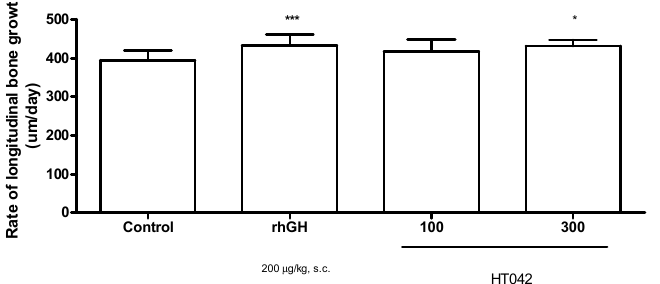
Figure 7. Longitudinal bone growth rate of proximal tibial growth plate of rats measured using fluorescent marker. Data are expressed as mean ± standard error ( n = 8 per group), * p < 0.05, *** p < 0.001.